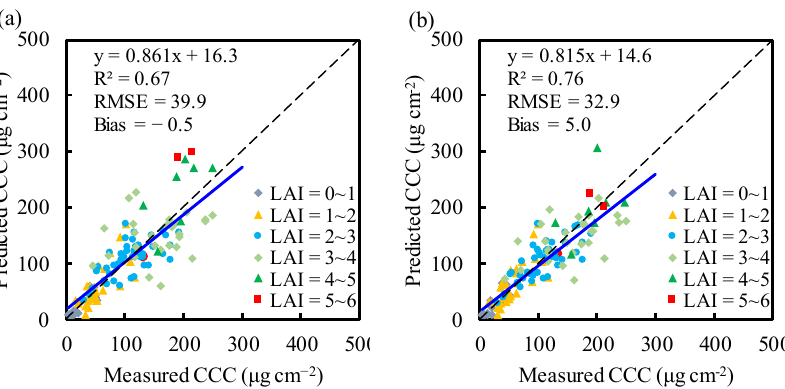
Figure 6. Accuracy of CCC retrieval characterized by LAIs for wheat and soybean using ground- measured continuous spectra ( a ) without and ( b ) with considering prior ALA adj knowledge related to crop types. ( a ) NonPrior-ALA_45_62 model; ( b ) Prior-ALA_45_62 model.